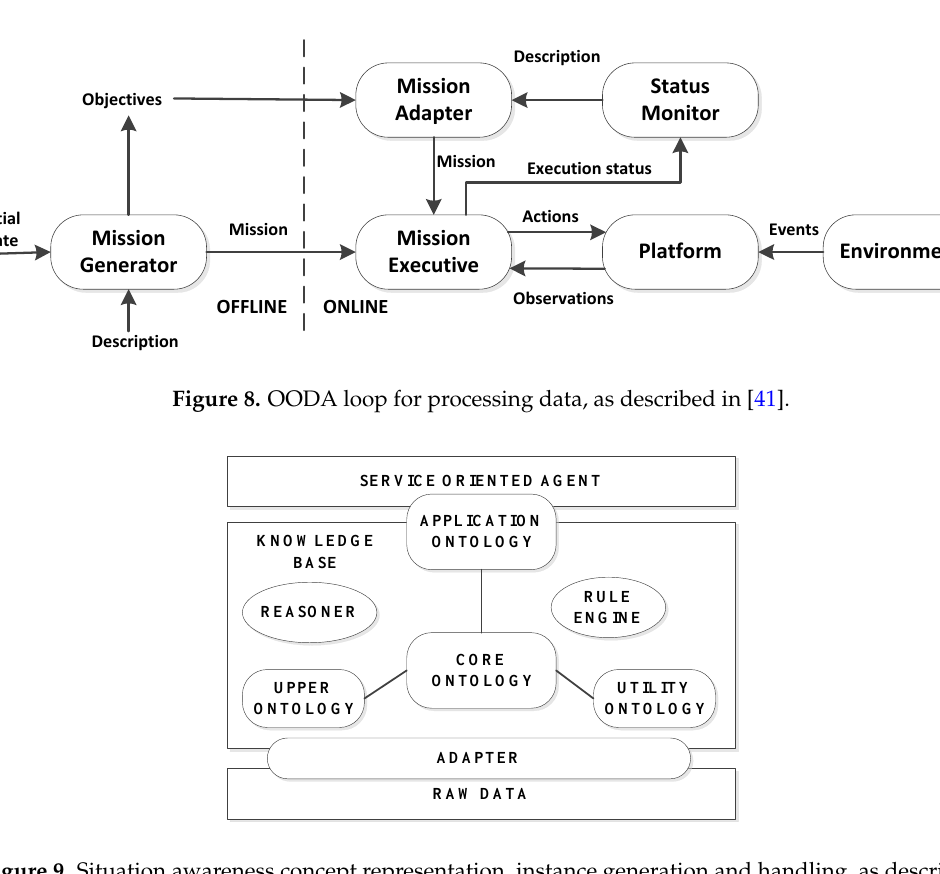
Figure 9. Situation awareness concept representation, instance generation and handling, as described in [41].